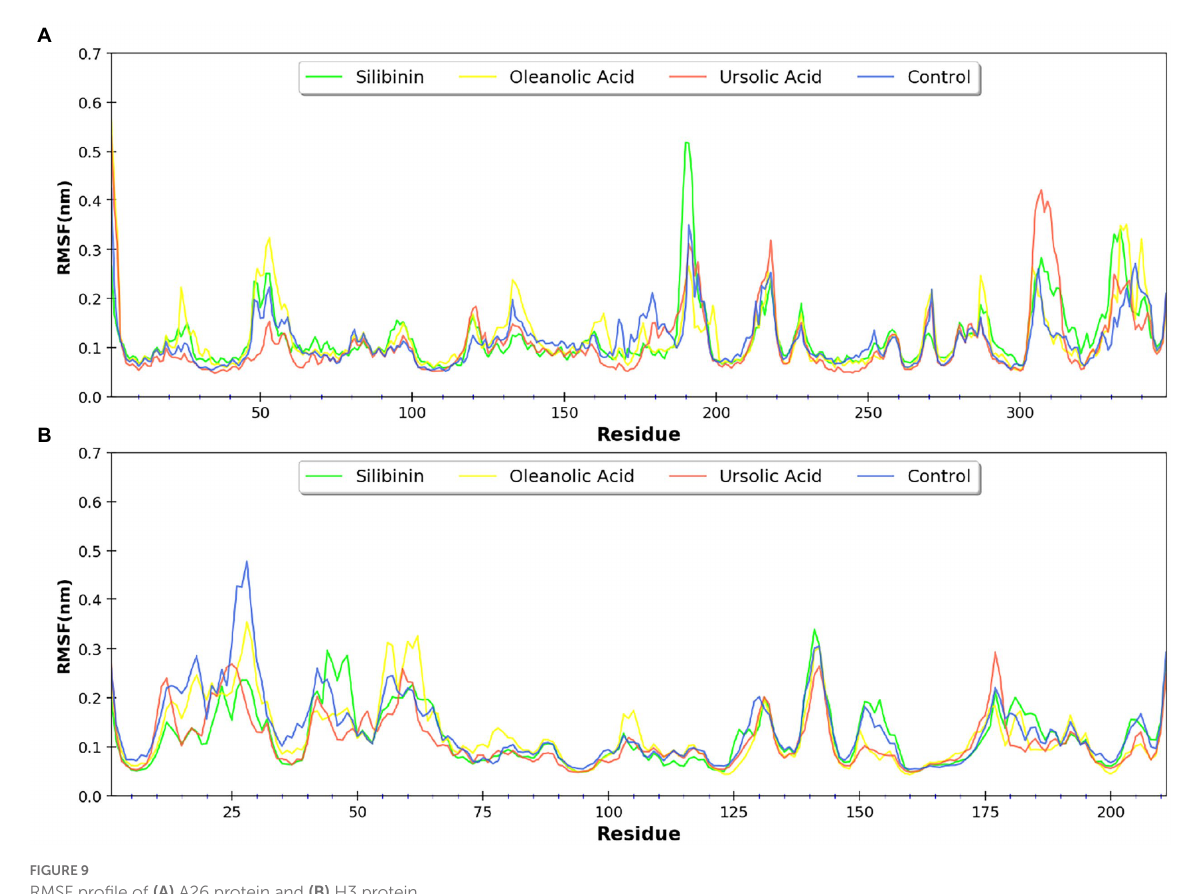
FIGURE 9 RMSF profile of (A) A26 protein and (B) H3